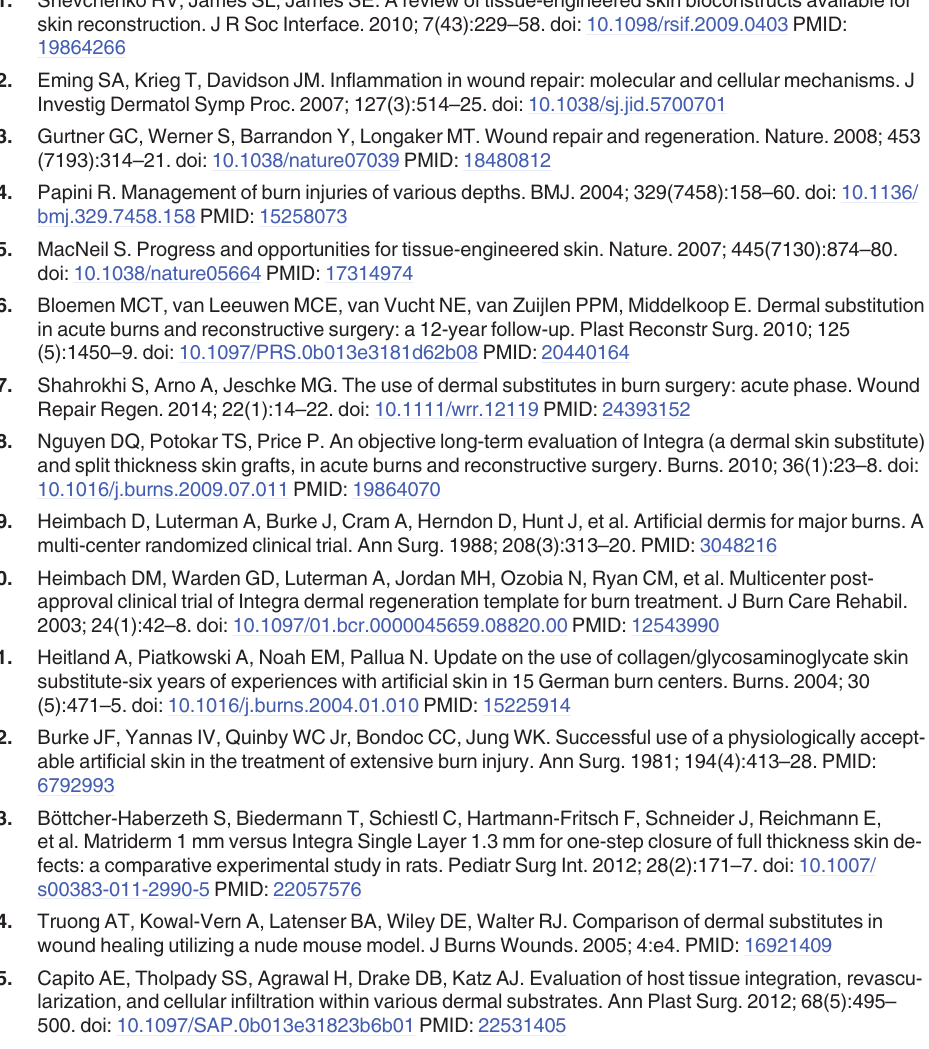
S3 Table. Quantification of blood vessels. Data of Fig. 4B. represent the individual measures and means expressed as blood vessels/mm 2 standard errors (SEM), the number of animal (n) and the P value between the animal